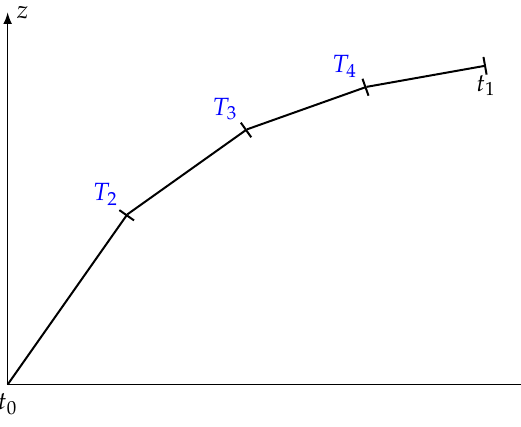
Figure 4. Approximation to the trajectory of a rocket by tangents with a constant flight path